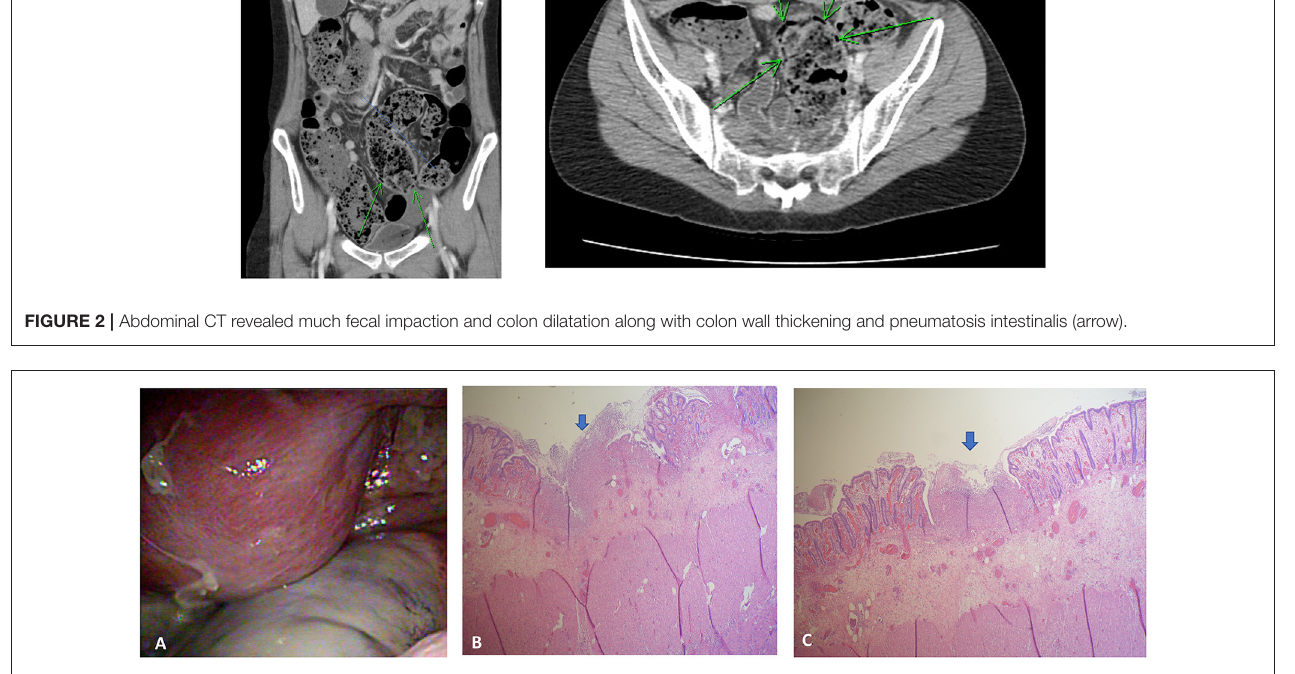
FIGURE 3 | (A) Exploratory laparoscopy revealed poor perfusion of the upper rectum with pericolonic fibrin and turbid ascites in the pelvic cavity. (B) The section showed ischemic change, intensive mucosal injury, and focal transmural necrosis of the large intestine (arrow). (C) The specimen showed focal ischemic change and transmural necrosis of the large